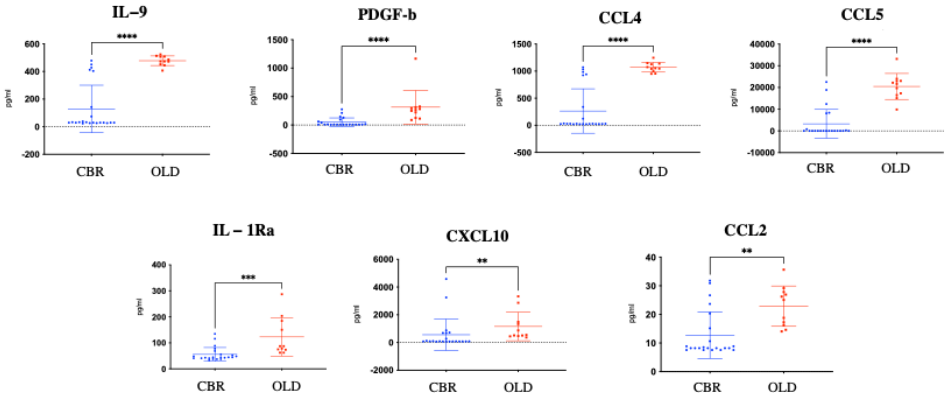
Figure 2. Graphs representing the plasma levels of the molecules found over-expressed in active OLD control individuals (red squares) with respect to CBR individuals (blue dots) as measured by Bio-Plex methodologies. The non-parametric Mann–Whitney test was used for statistical comparison between the two examined groups. p -values for each statistically significant comparison have been reported (** p < 0.01; *** p < 0.001; **** p <